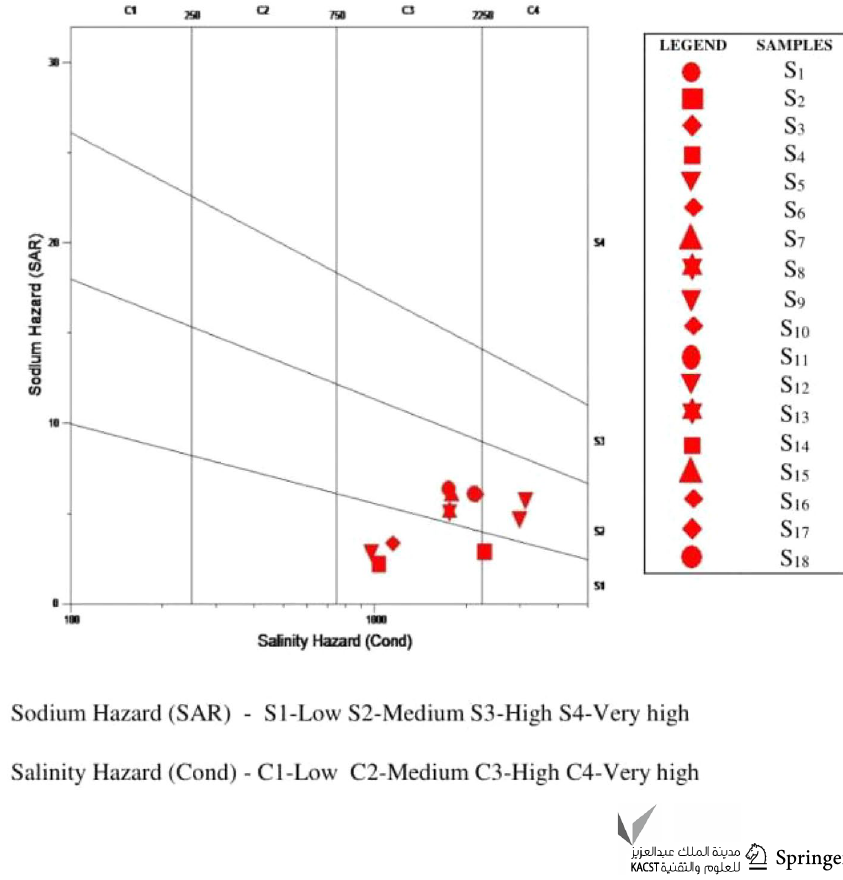
Fig. 3 USSL diagram of 18 groundwater samples of Batlagundu block in Dindigul district. SAR Sodium